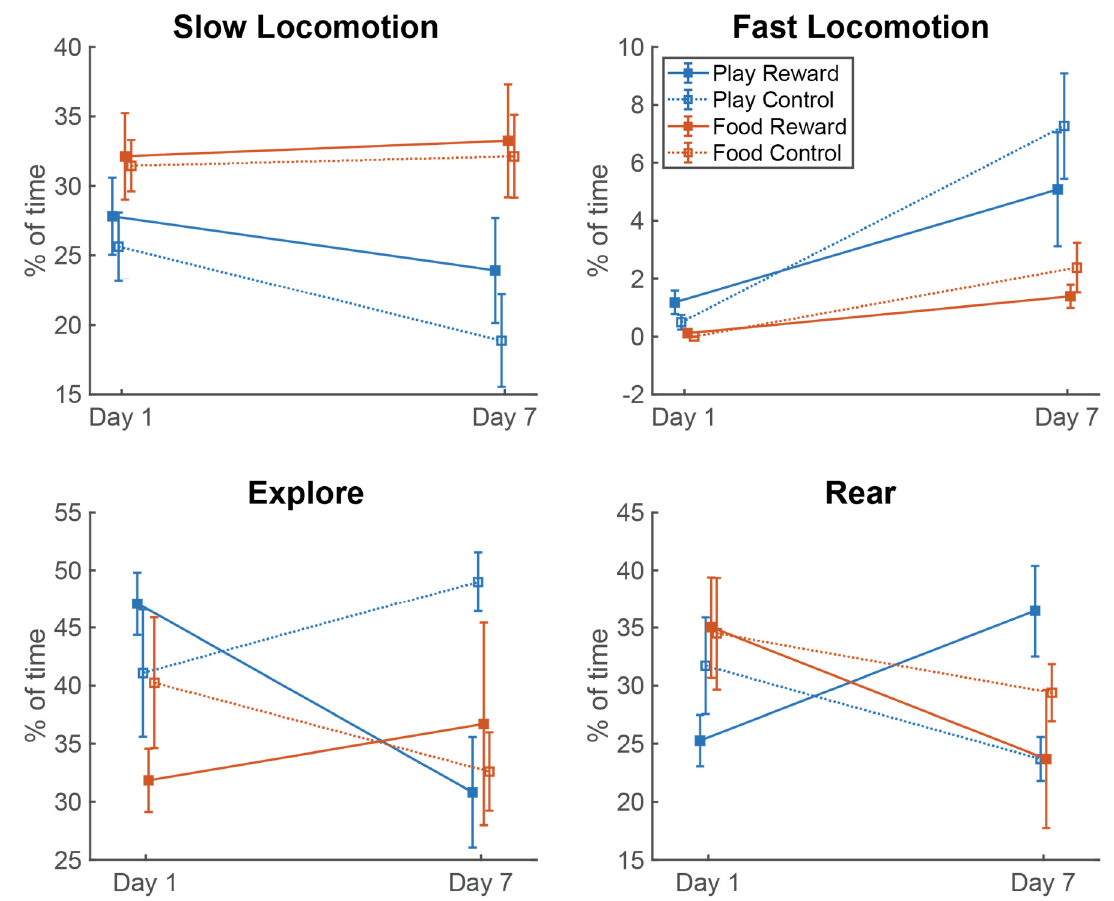
Figure 5. The average proportion of time spent in each of several key behaviors on day 1 and day 7 for each experimental group. Upper left shows the proportion of the 2 min test period spend in slow locomotion (single step, turn or walk). Upper right shows proportion of time spent in fast locomotion (running or jumping). Lower left shows time spent in exploratory behaviors. Lower right shows time spent rearing on hind legs. All error bars are standard error of the mean.